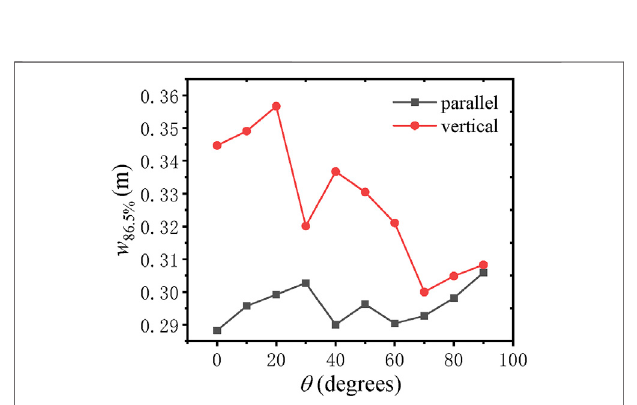
FIGURE 5 | Variation of beam width w 86.5% with rotating angle θ for different arrangements of the central beamlet.